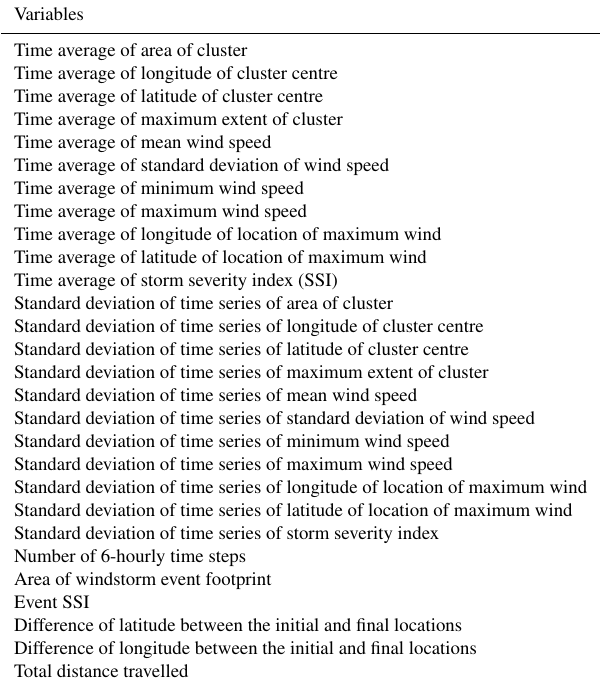
Table 2. List of explanatory variables which are initially considered in the LRC model.